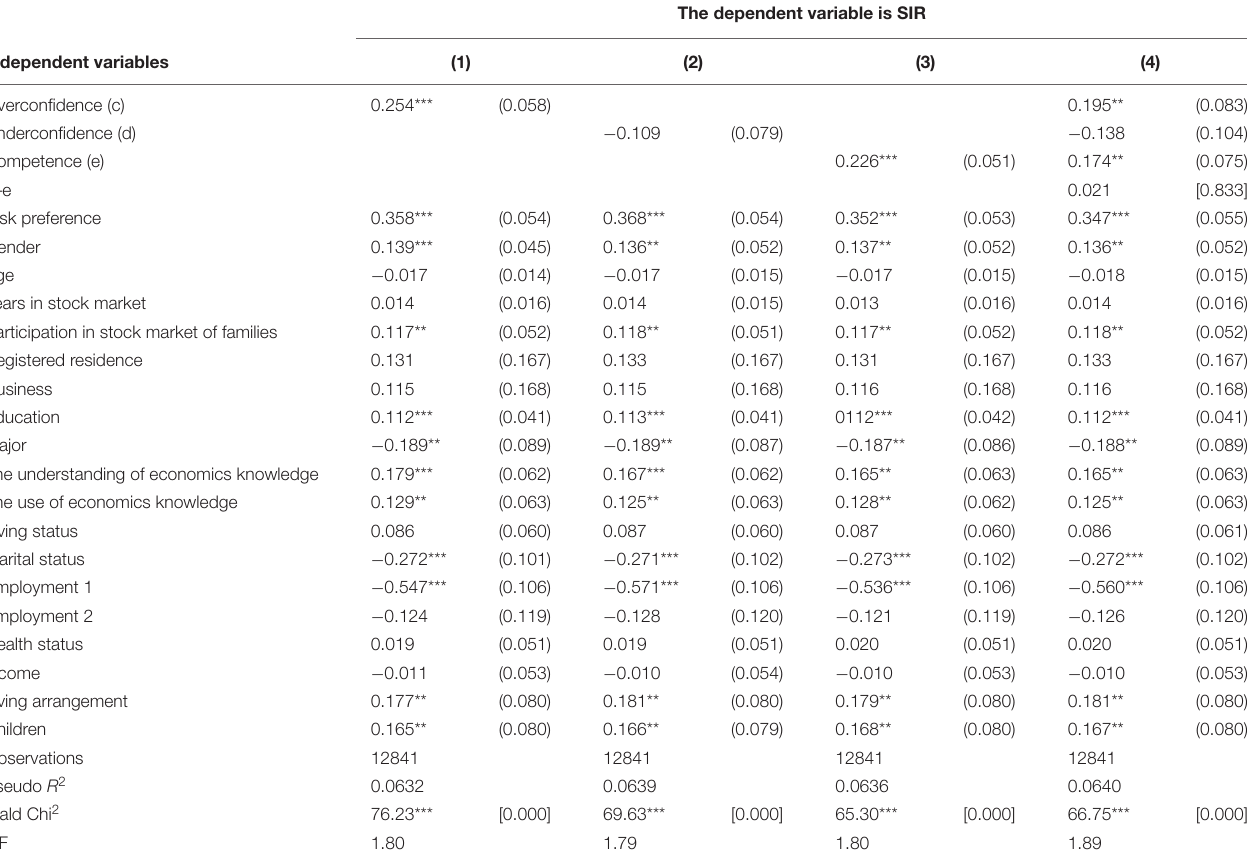
TABLE 9 | The Ordered Probit regression results of the relationship between composite FL and SIR.